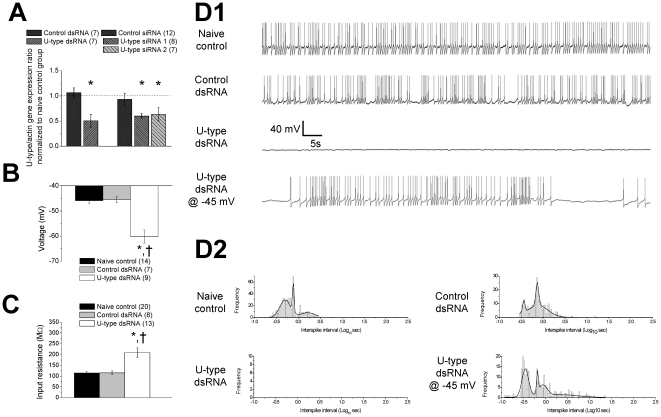
Effects of the U-type dsRNA on rhythmic firing and intrinsic membrane
properties in RPeD1 neurons.(A) U-type specific dsRNA/siRNA in vivo knockdown was
confirmed with real-time qPCR analysis. Expression ratio of the U-type
channel to β-actin mRNAs in different experimental groups was
normalized to naïve control ratio: control dsRNA
(n = 7), U-type dsRNA (n = 7),
control siRNA (n = 12), U-type siRNA 1
(n = 8), and U-type siRNA 2
(n = 7). * indicate significant difference
(P<0.05) to the corresponding control dsRNA or control siRNA
treatment. Isolated individual RPeD1 neurons were maintained in culture
in conditioned media (CM), CM + control dsRNA, or CM + U-type
dsRNA, and recording was conduced within 24 hours following isolation.
(B) Average resting membrane potentials of naïve control
(n = 14), control dsRNA
(n = 7), and U-type dsRNA
(n = 9) treated neurons recorded 2 min after
impaling cells. (C) Average input resistance of naïve control
(n = 20), control dsRNA
(n = 8), and U-type dsRNA
(n = 13) treated neurons. (D1) Representative
action potential traces of naïve control, control dsRNA, and U-type
dsRNA pre-treated neurons recorded at resting membrane potentials, and
U-type dsRNA pre-treated neuron depolarized to −45 mV. (D2)
Distribution curves of inter spike durations for naïve control
neurons (n = 10), control dsRNA neurons
(n = 4), U-type dsRNA neurons
(n = 5), and U-type dsRNA neurons
(n = 5) depolarized to −45 mV. Total
inter-spike count is 940 in naïve control, 346 in control dsRNA, 0
in U-type dsRNA, and 304 in U-type dsRNA depolarized to −45 mV.
Distributions were best fitted with 4 terms Gaussian curve. All
significant difference (P<0.05) between naïve control and U-type
dsRNA treatment is denoted by *. All significant different
(P<0.05) between control dsRNA and U-type dsRNA treatment is denoted
by †.